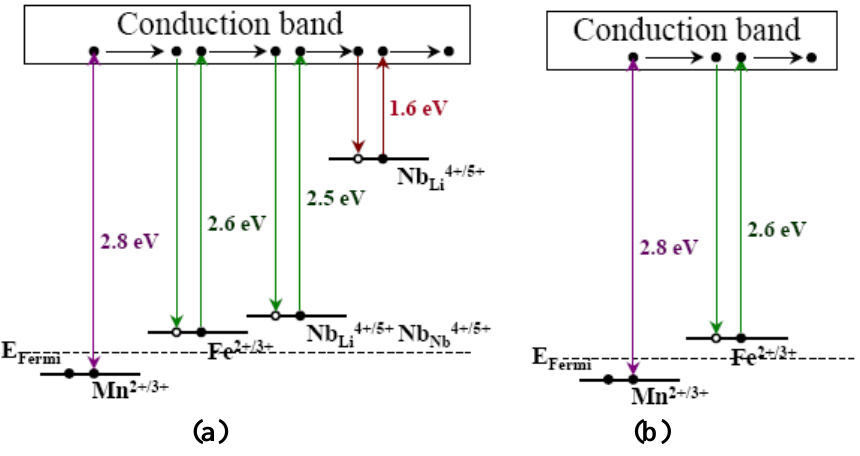
Figure 4. Energy level diagram of dopants and intrinsic defects in the forbidden gap of LiNbO . ( a ) Normal congruent LiNbO , doubly doped with iron and manganese, where the 3 3 energy levels of small polaron (Nb Li4+ ) and bipolaron (Nb Li4+ Nb Nb4+ ) also exist; ( b ) Ideal doubly doped LiNbO [72]. 3